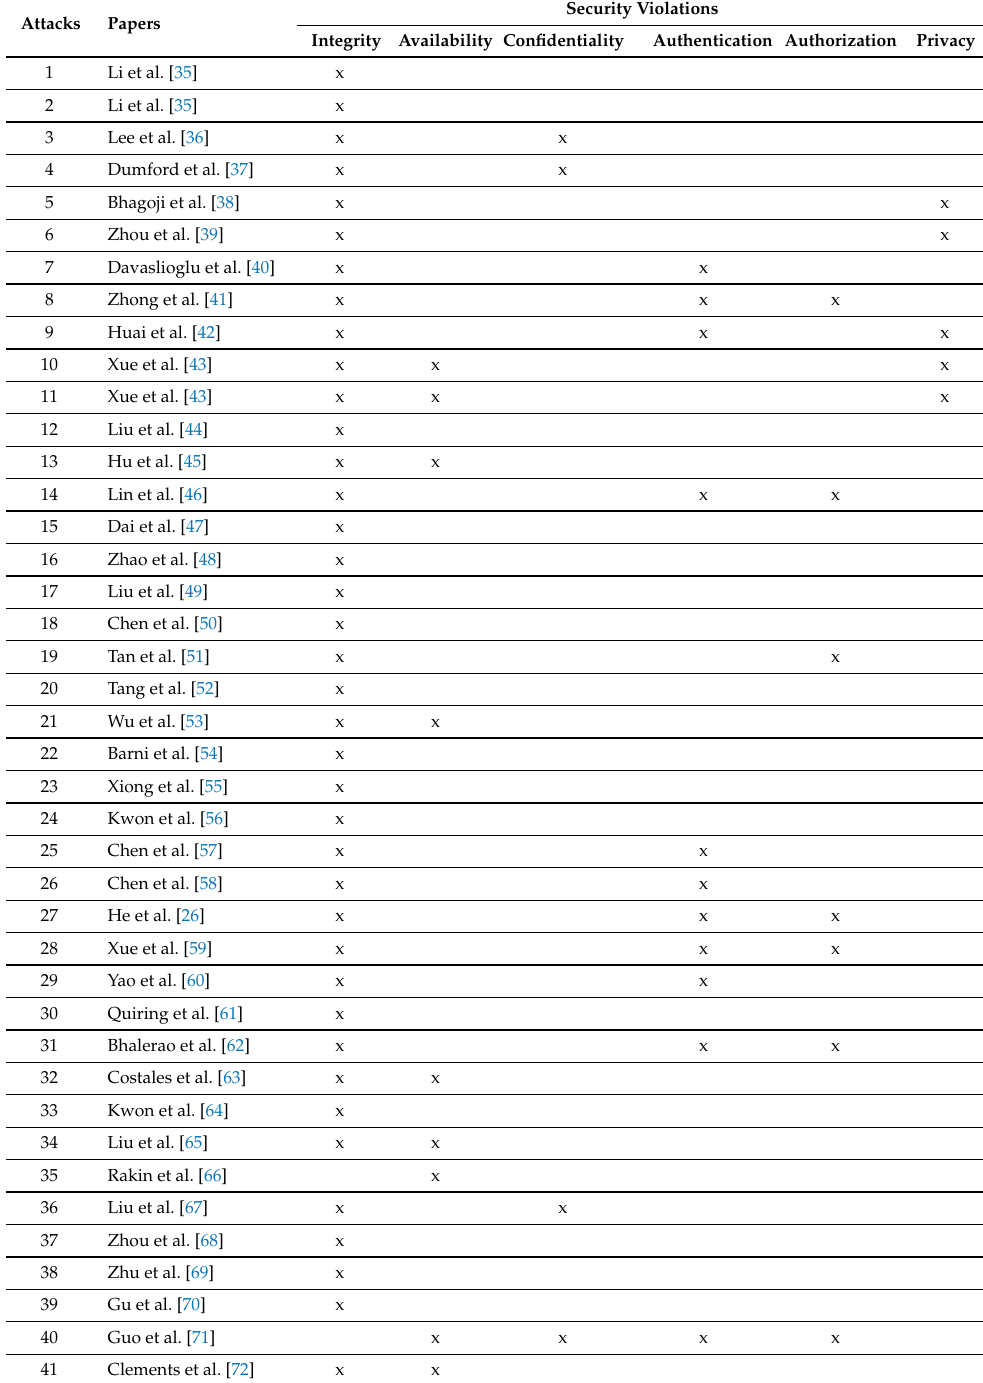
Table 4. A summary of security violations for each